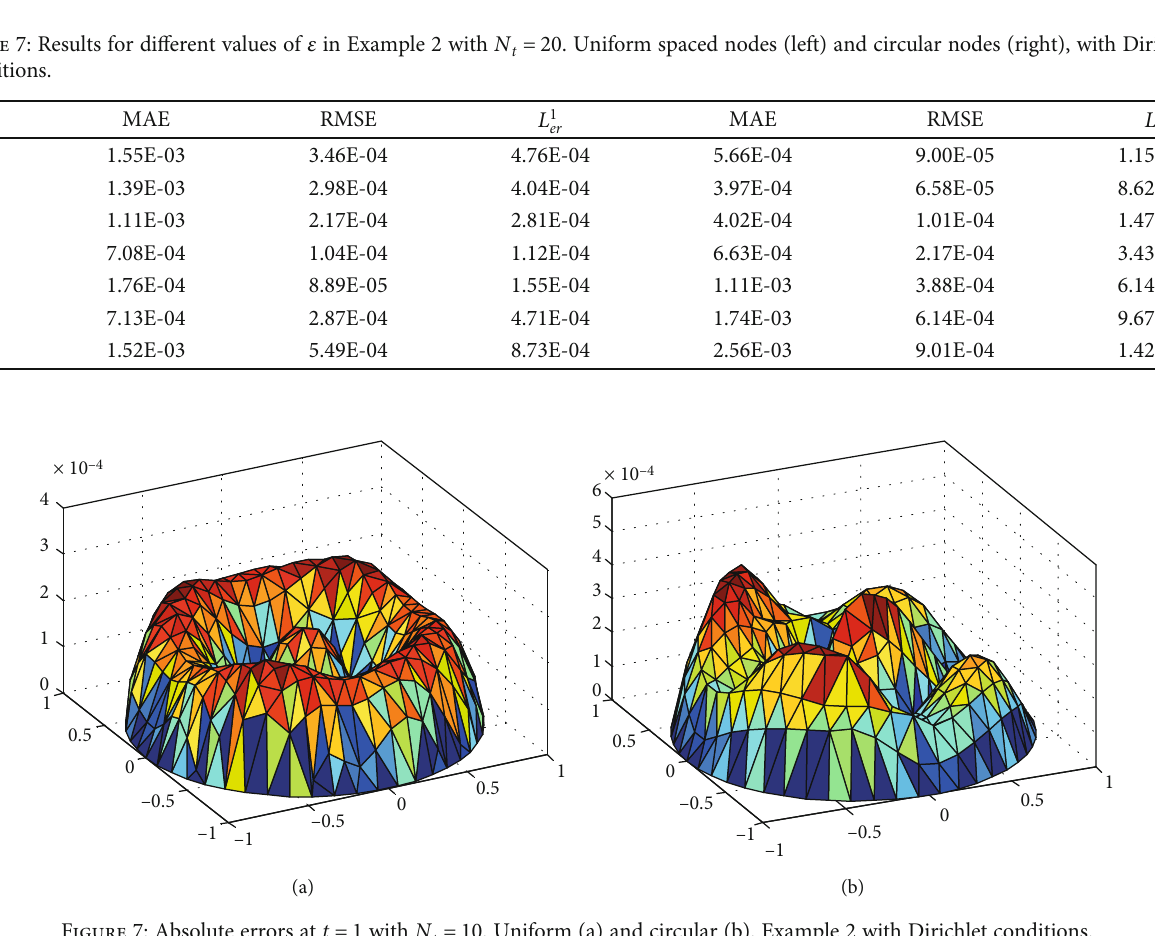
Figure 7: Absolute errors at t = 1 with N